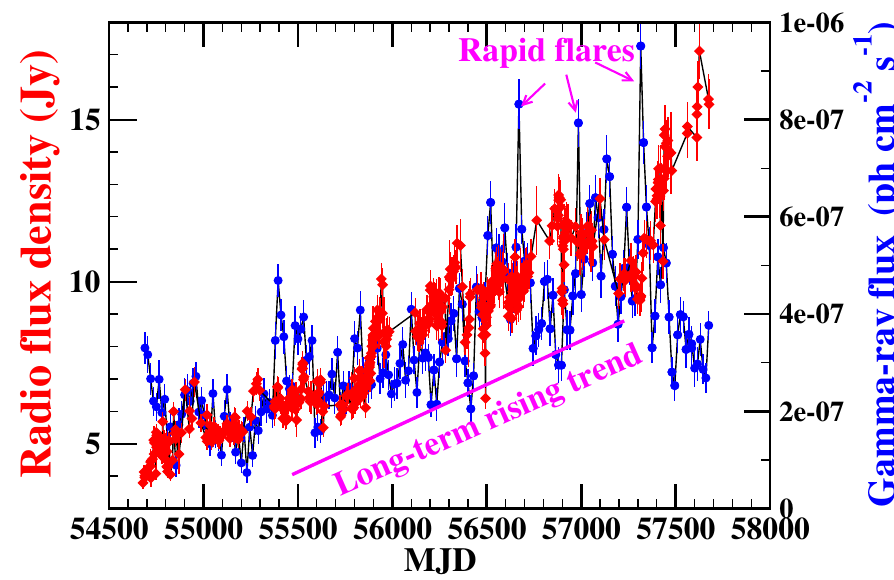
Figure 5. Gamma-ray photon flux (blue) and radio 230 GHz (red) light curve of the TeVRad 3C 84 at E = 0.1–300 GeV. The γ -ray light curve is produced by adaptive binning analysis method following Lott et al. [89] using the Fermi /LAT data from August 2008 until September 2017 . The radio 230 GHz light curve is from sub-millimeter array (SMA) AGN monitoring program (details are refereed to Hodgson et al. [8]). Rapid flares superimposed on top of the long-term rising trend can be seen both at γ -ray and radio frequencies.